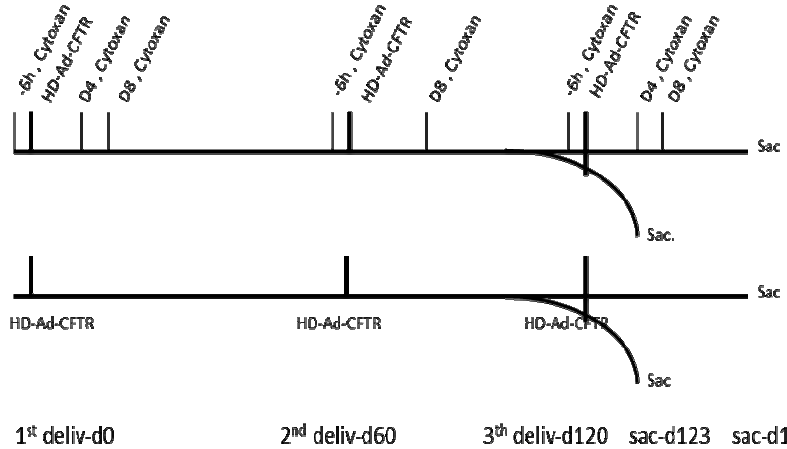
Figure 1. Time frame of the helper-dependent adenoviral (HD-Ad) vector transduction and cyclophosphamide administration. All the mice were nasally delivered HD-Ad- CFTR at a dose of 1.5 × 10 10 viral particles in 3 rounds, each indicated by a heavy vertical line. The date of the first round of vector delivery is called d0. The second and third round was given at day 60 and day 120, respectively, following the first round. A cyclophosphamide (cytoxan) injection was administered at 6 h before ( − 6 h) and 4 (d4) and 8 days (d8) following the vector delivery. However, there was a glitch in the scheme where the cyclophosphamide injection at day 4 for the second round of vector delivery was missed. The samples were collected at days 3 and 33 after the last round of vector delivery, as shown in the scheme. Deliv: delivery; sac: